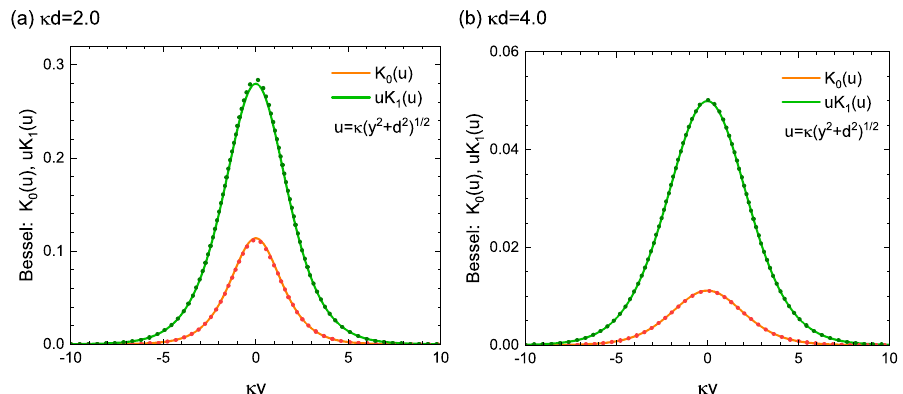
Figure 8. Symmetric peak of K 0 ( u ) and uK 1 ( u ) around the point of y = 0 (solid curve). The variable (cid:112) u is defined by u = κ y 2 + d 2 . Approximated curves, given by Equations (48) and (49), are also plotted by dotted curves. The edge dislocation is assumed to be located at ( x , y ) = ( − d ,0 ) with ( a ) d = 2.0 and ( b ) d =